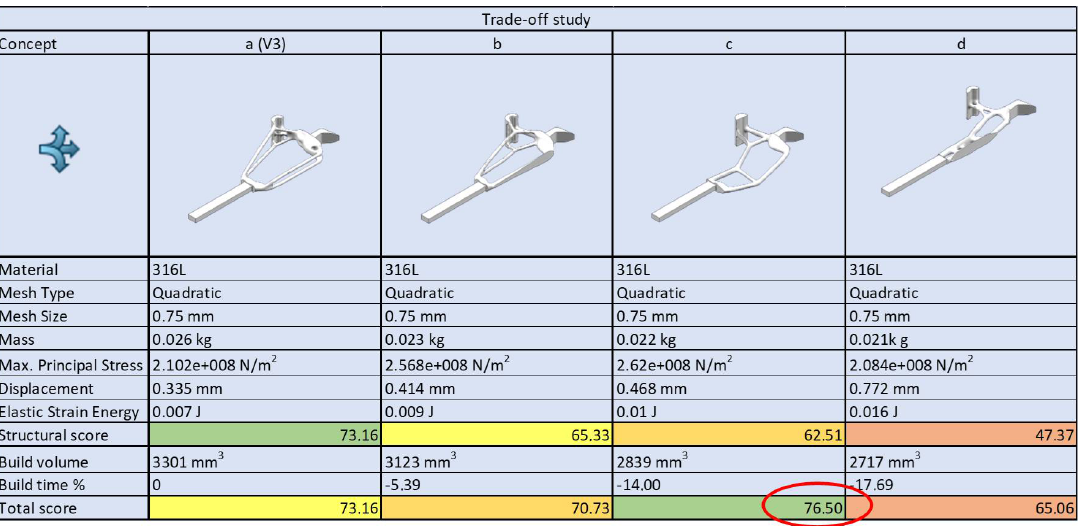
Figure 11. Key performance indicators (KPIs) matrix involved in the trade-o ff study step: the four concepts ( a – d ) are compared in the columns.